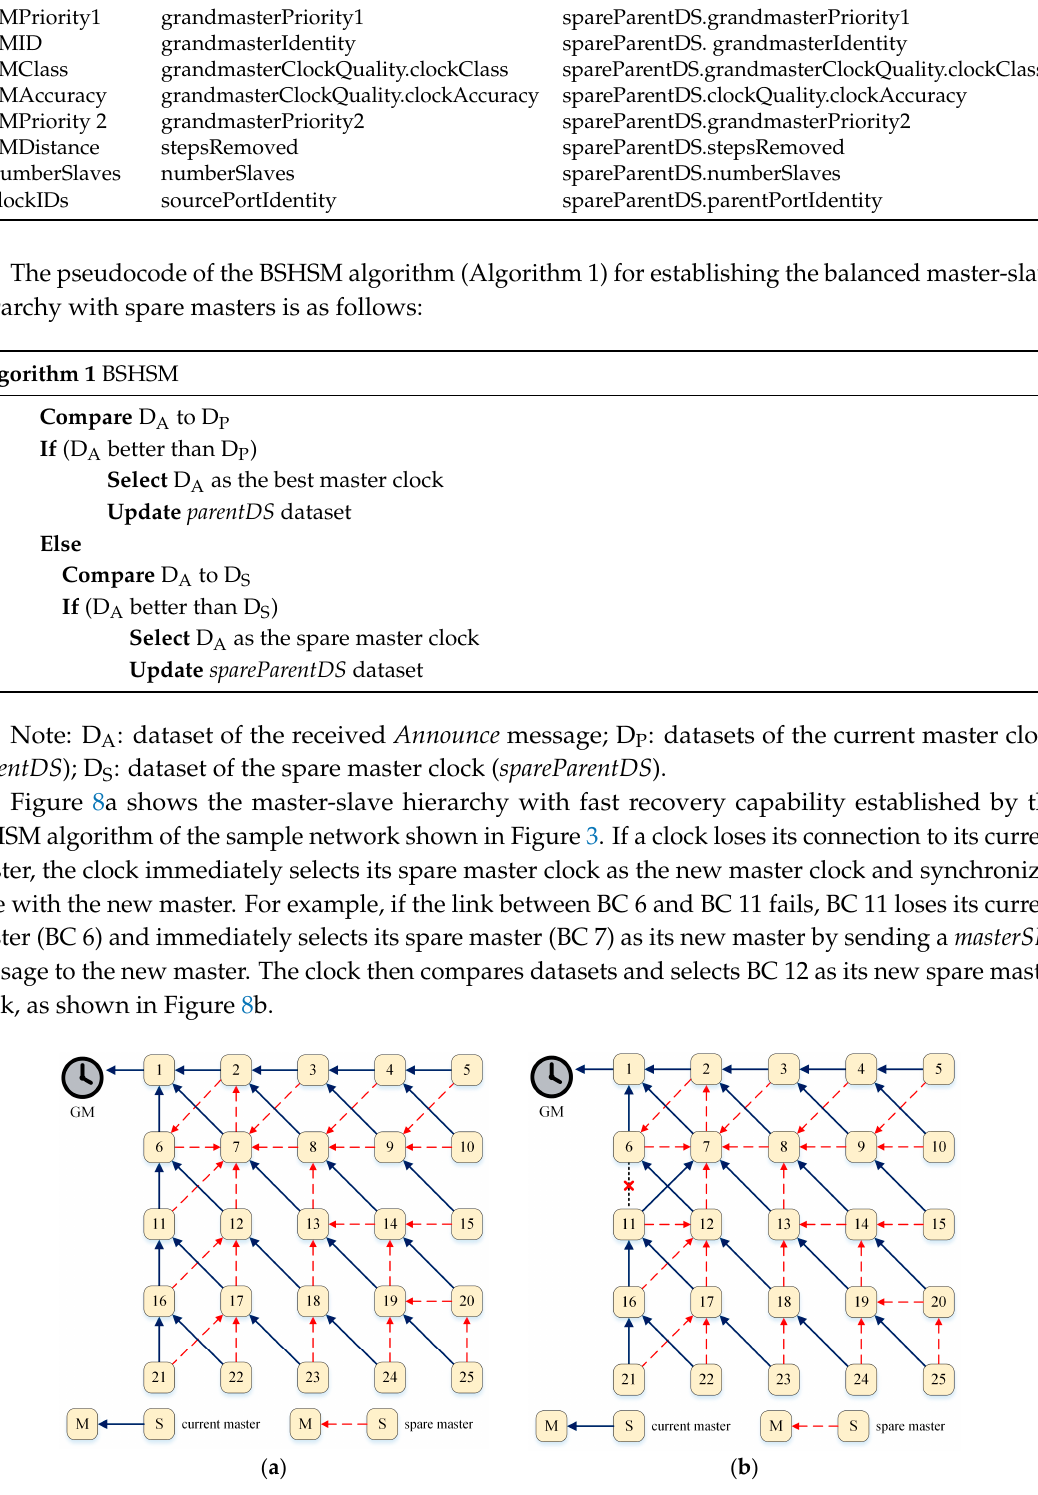
Table 3. Information sources for the dataset comparison used to select the spare master in the BSHSM algorithm.